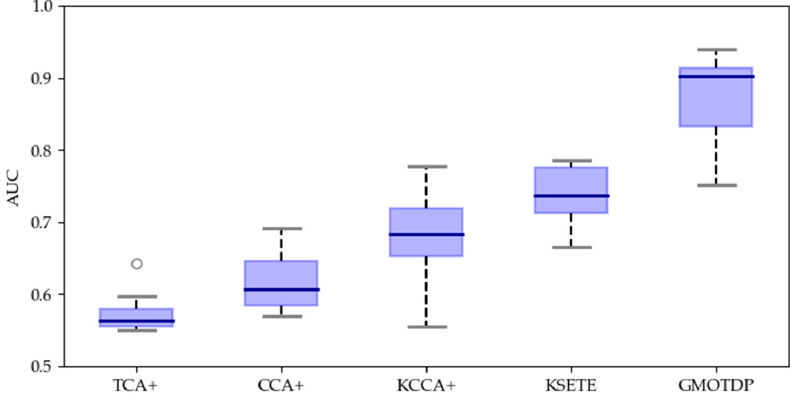
Figure 7. Boxplot for source and target projects without common features using different methods. Table 5. Mean AUC results for source and target projects without common features using different methods.